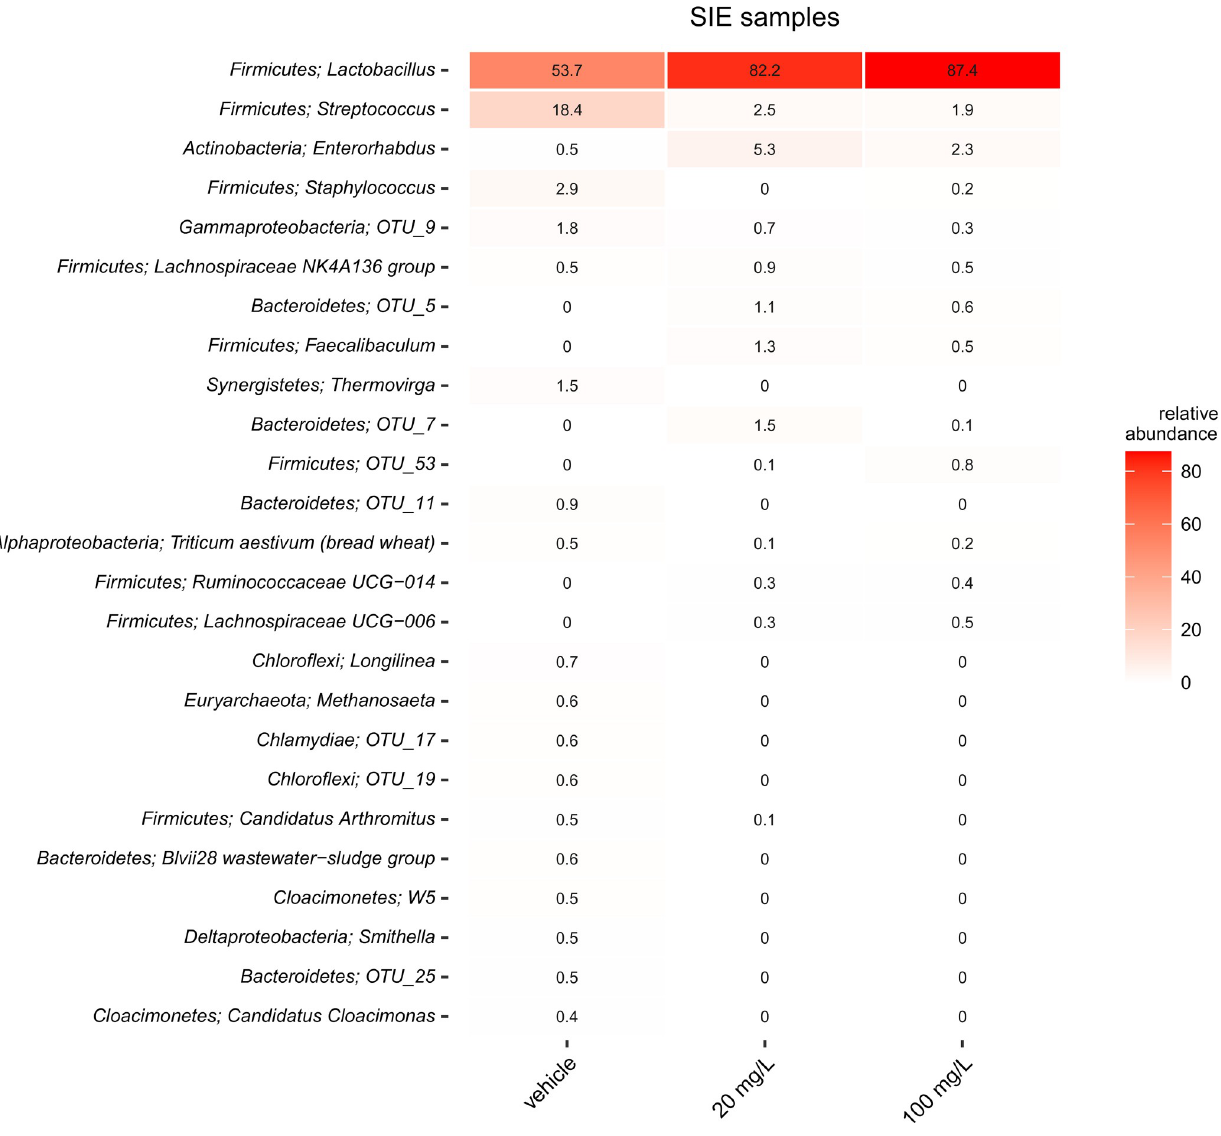
lowest assigned taxonomic classification is given. Values are shown as normalized fraction of total sequences